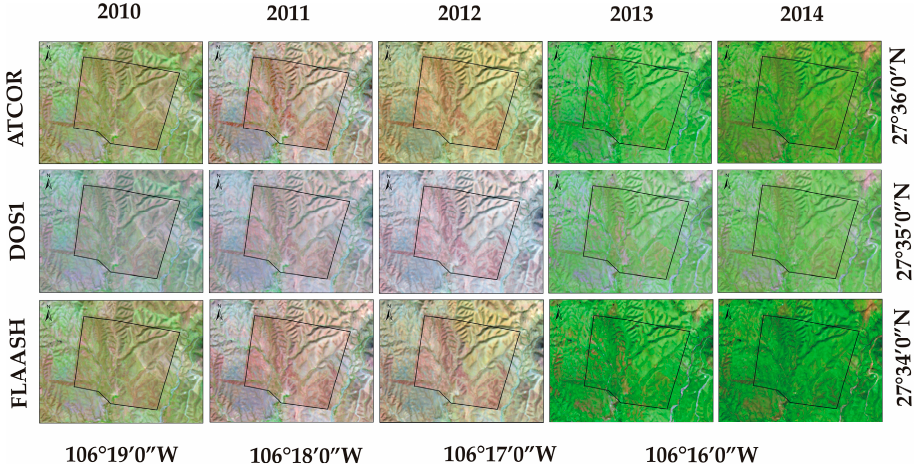
Figure 3. False-color images from the different radiometric correction algorithms. Site: Eden.